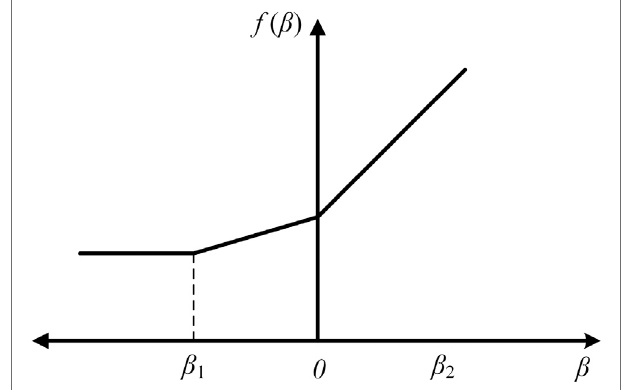
FIGURE 2 | β (cid:1) 0 is a breakpoint.